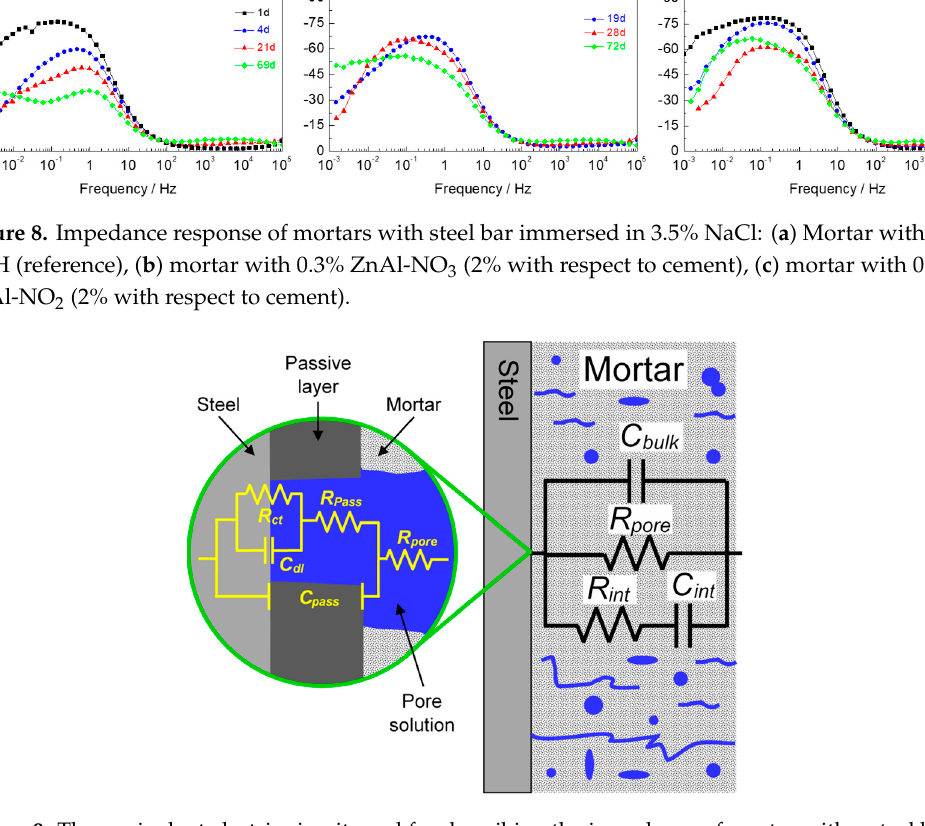
Figure 9. The equivalent electric circuit used for describing the impedance of mortar with a steel bar.